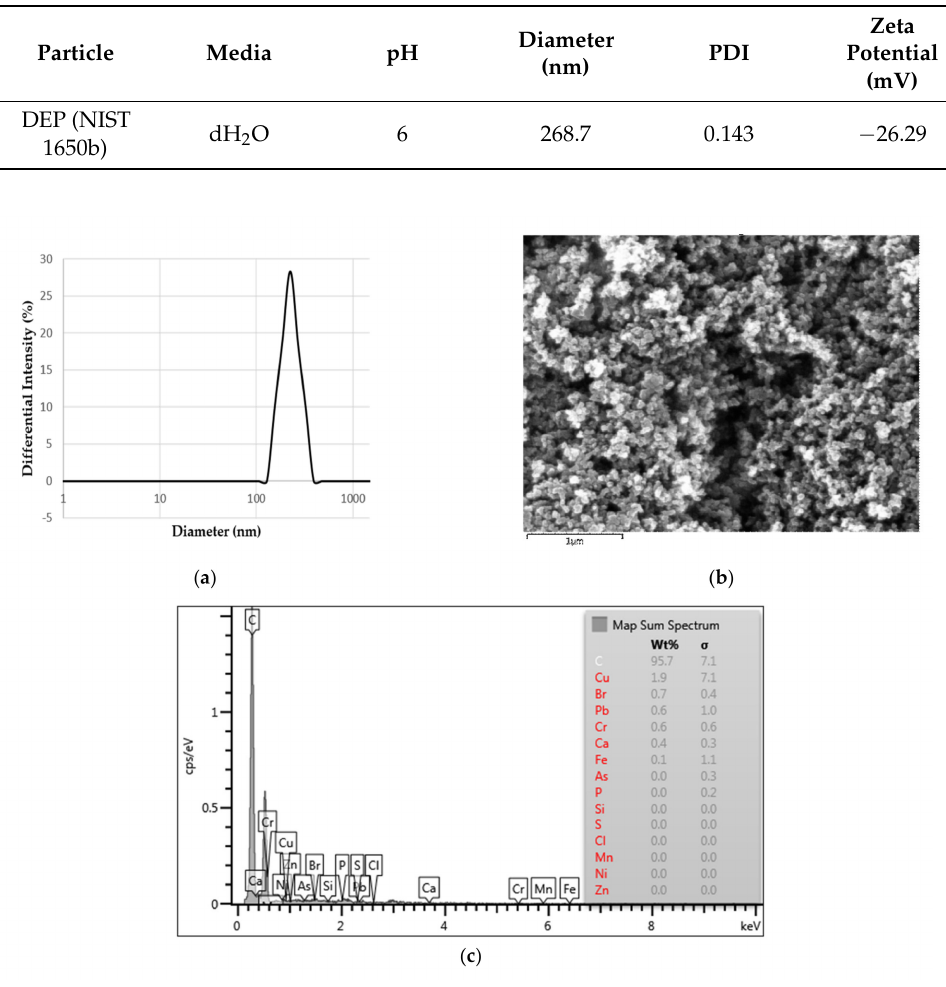
Table 1. Characteristics of the prepared fine particles.